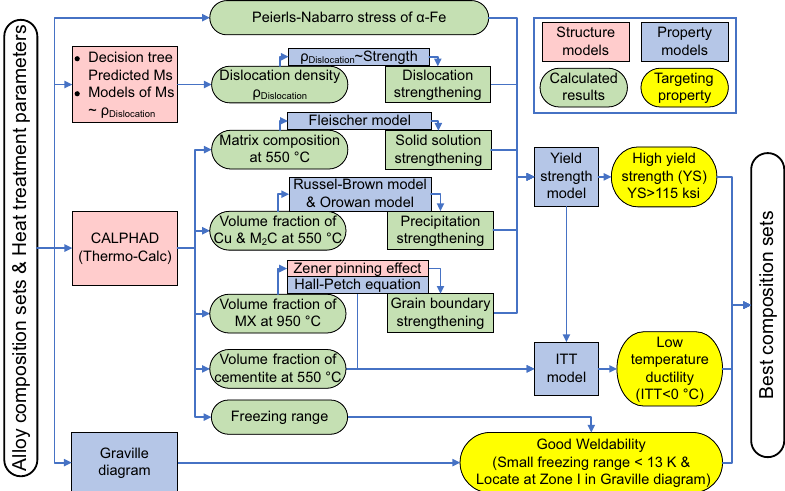
Fig. 2 ICME modeling work fl ow for HSLA-115 steel composition design. The pink box denotes structure models predicting features such as phase fraction of different phases, dislocation density based on composition and heat treatment process; the blue box denotes the property models which can simulate the strength, freezing range, etc. based on structure and compositions; the green box denotes the calculated property or structural information from the models; the yellow box denotes the target properties.